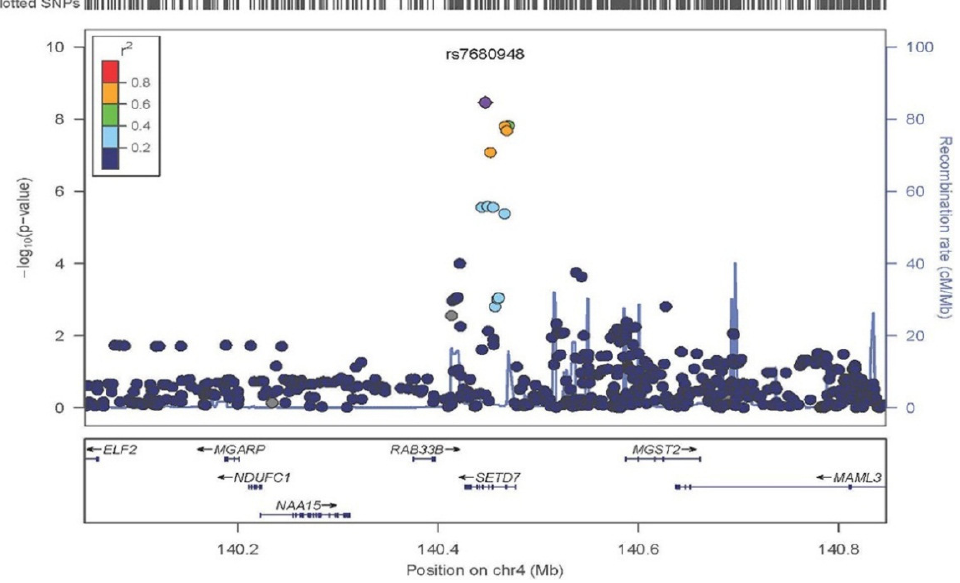
Figure 1. Manhattan plot for the genome ‐ wide association study (GWAS) of serum lycopene concentrations in the Old Order Amish study population following a 6 ‐ day controlled diet. The x ‐ axis represents chromosomal position along the genome. The y ‐ axis shows the p ‐ value for association test at each locus on the log scale. The colors are used to identify the different chromosomes listed on the x ‐ axis. Table 2. Genome ‐ wide ( p < 5 × 10 − 8 ) and sub genome ‐ wide (5 × 10 − 8 ≤ p < 1 × 10 − 6 ) associations with serum lycopene concentrations.